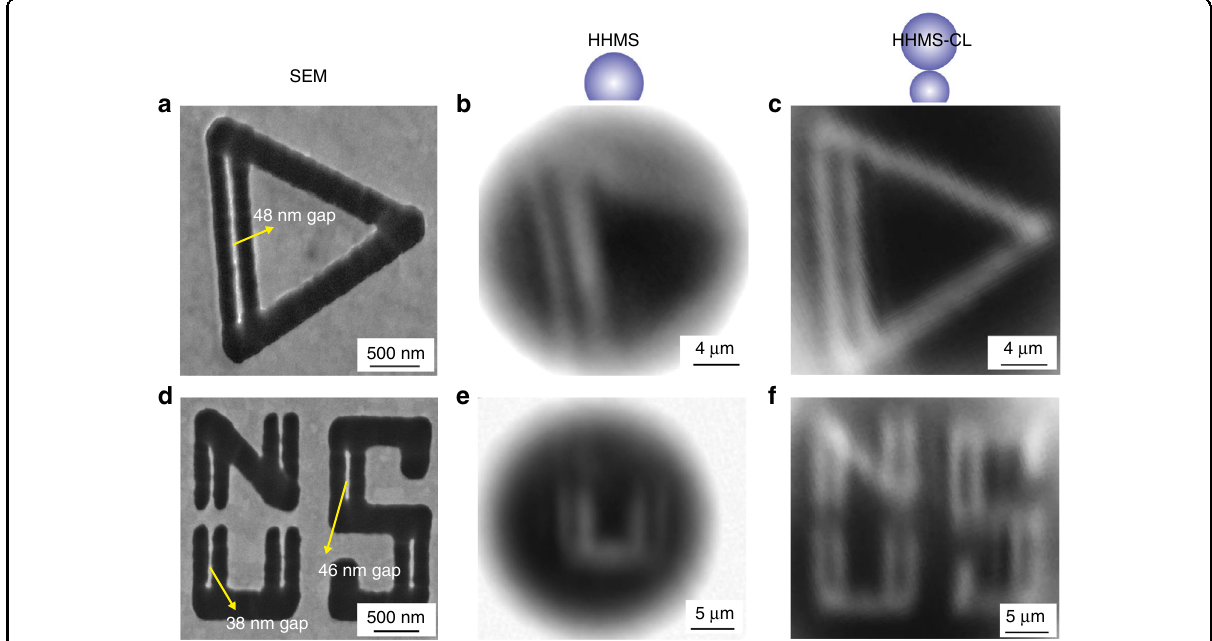
Fig. 5 Imaging comparison between the HHMS and HHMS-CL. Triangular pattern and “ NUS ” letters imaged by ( a ) and ( d ) SEM, b and e single HHMS being coupled with a 10× objective lens, c and f HHMS-CL being coupled with 10× objective lens. The minimum feature sizes in the two patterns are 48 and 38 nm,